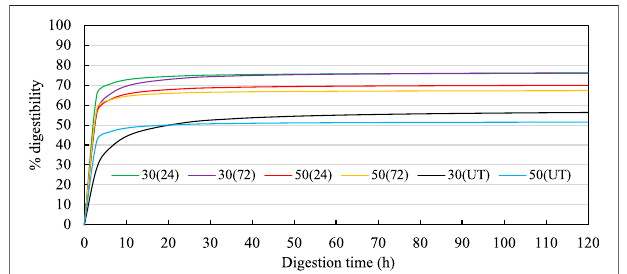
FIGURE 3 | Enzymatic digestibility curves for treated DDGS. In the legend, the fi rst numbers indicate the MC (%db), the numbers in the parentheses indicate the incubation time (h). Hanes-Woolf linear regressions used to estimate the digestibilites over time were 30 (24): Y (cid:2) 0.0131x + 0.0065; 30 (72): Y (cid:2) 0.013x + 0.0138; 50 (24): Y (cid:2) 0.0142x + 0.0106; 50 (72): Y (cid:2) 0.0148x + 0.0071; 30(UT): Y (cid:2) 0.0173x + 0.0529; 50(UT): Y (cid:2) 0.0193x + 0.0131. UT indicates untreated DDGS.